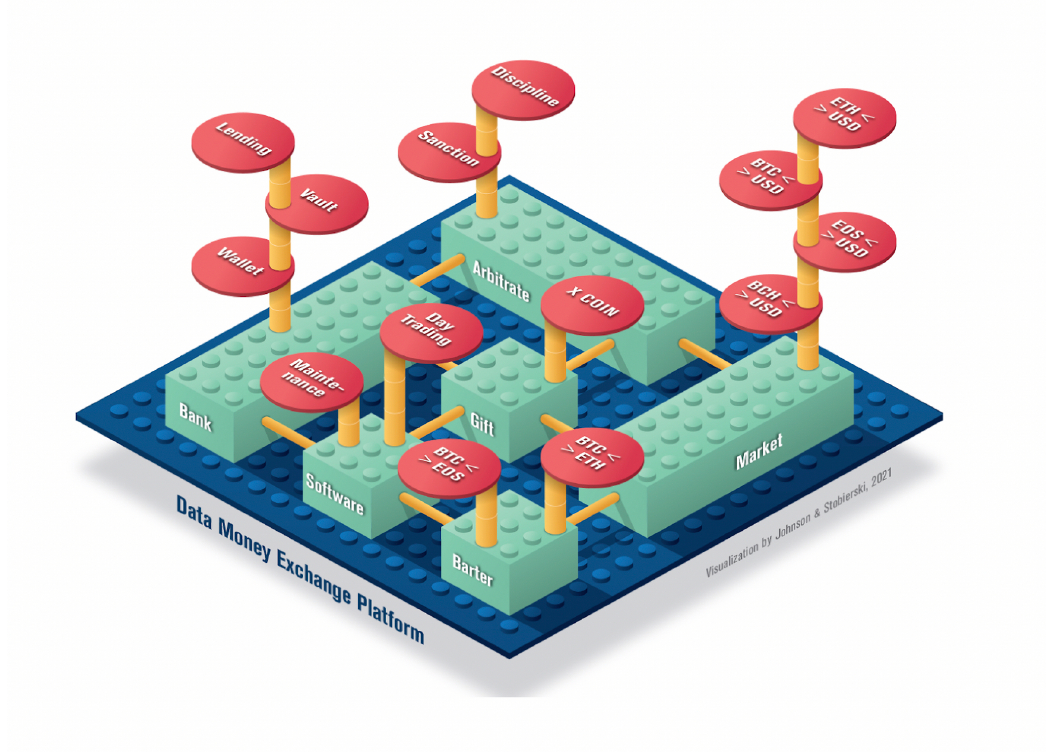
Figure 6: Visualization of Stack Economization in a Cryptocurrency Exchange